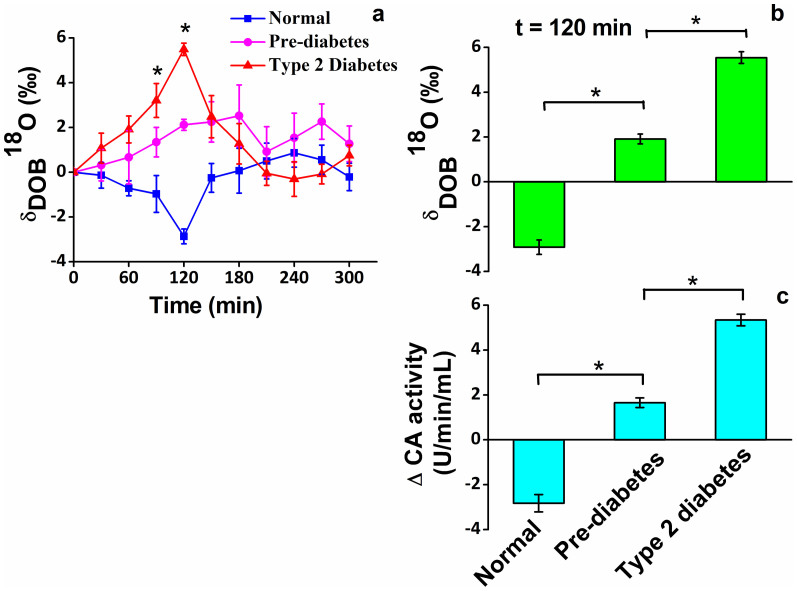
Erythrocyte ΔCA activity links with the δDOB
18O of breath CO2 for non-diabetic control (NDC), pre-diabetes (PD) and type 2 diabetes (T2D).(a), The maximum difference (p < 0.0001) of δDOB
18O (‰) was found at 120 min after glucose load. (b), (c), The ΔCA activities for T2D (5.34 ± 0.26), PD (1.65 ± 0.21) and NDC (−2.82 ± 0.38)] closely associated with δDOB
18O (5.54 ± 0.26, 1.91 ± 0.21 and −2.92 ± 0.32 for T2D, PD and NDC, respectively) in exhaled breath. *p < 0.01. Values are means ± SEM.